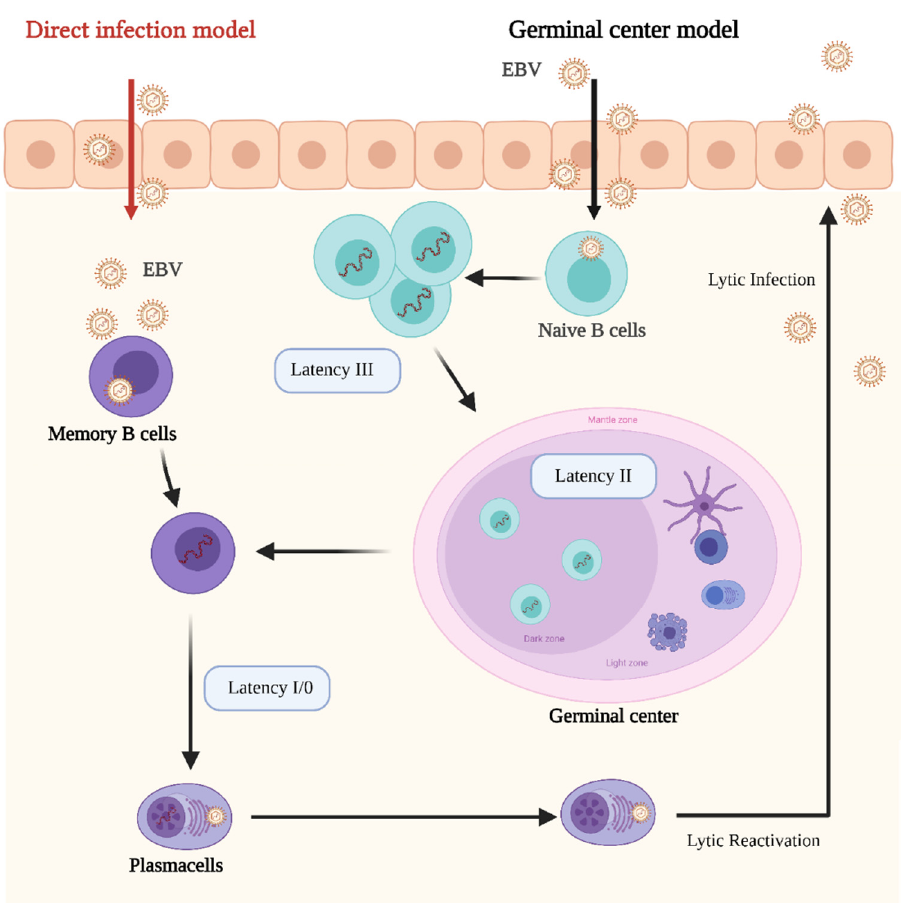
Figure 1. Schematic representation of the Epstein–Barr Virus (EBV) life cycle and latency stages. In the germinal center model EBV infects submucosal naive B cells and establishes the latency III program. In this stage the proliferation and expansion of the infected B cell pool is driven by the expression of all the EBV latent genes. Then, the infected cells enter in the germinal center, where they proliferate and mature. At this stage the Latency II program is established. Some infected B cells leave the germinal center as memory B cells. At this stage EBV infection is still latent (latency I/0), however, if infected memory cells differentiate in plasma cells and lytic reactivation is triggered. In the direct infection model, memory B cells are directly infected. Credits: Created with